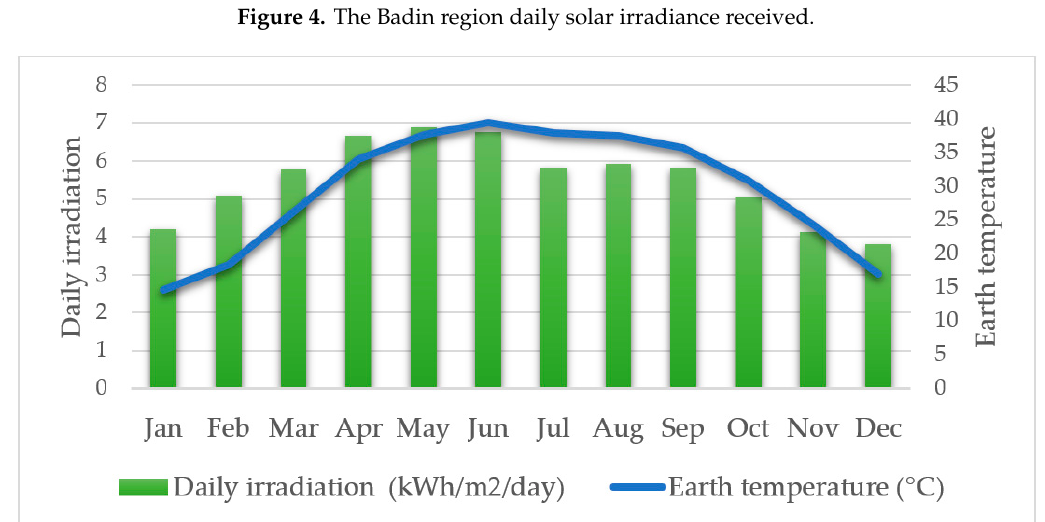
Figure 5. The Nawabshah region daily solar irradiance received.